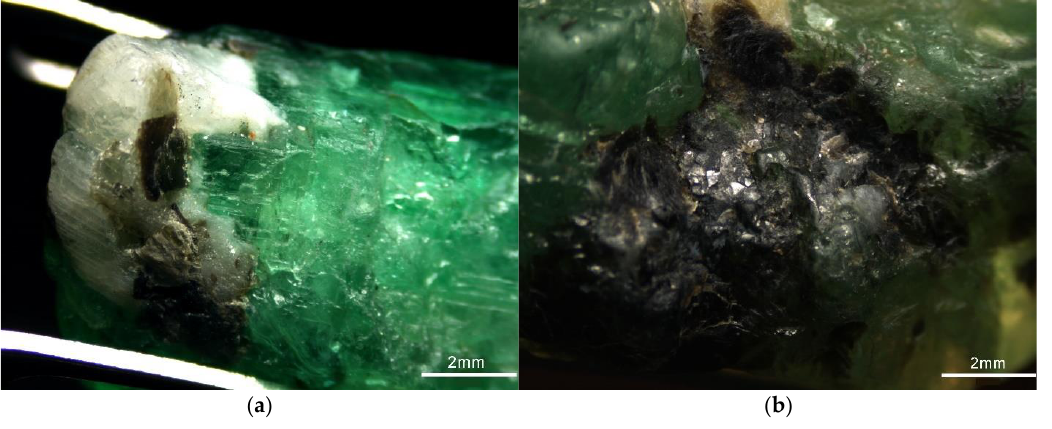
Figure 3. ( a ) Sample 94-5: White albite at one end of the surface of the hexagonal column and platelets of phlogopite; ( b ) Sample 94-4: Phlogopite and aragonite on emerald surfaces. Standard gemological properties of all the samples were determined with a refractometer, a Chelsea filter, long-wave (365 nm) and short-wave (254 nm) UV lamps, DiamondView TM , and an apparatus for hydrostatic specific gravity testing.